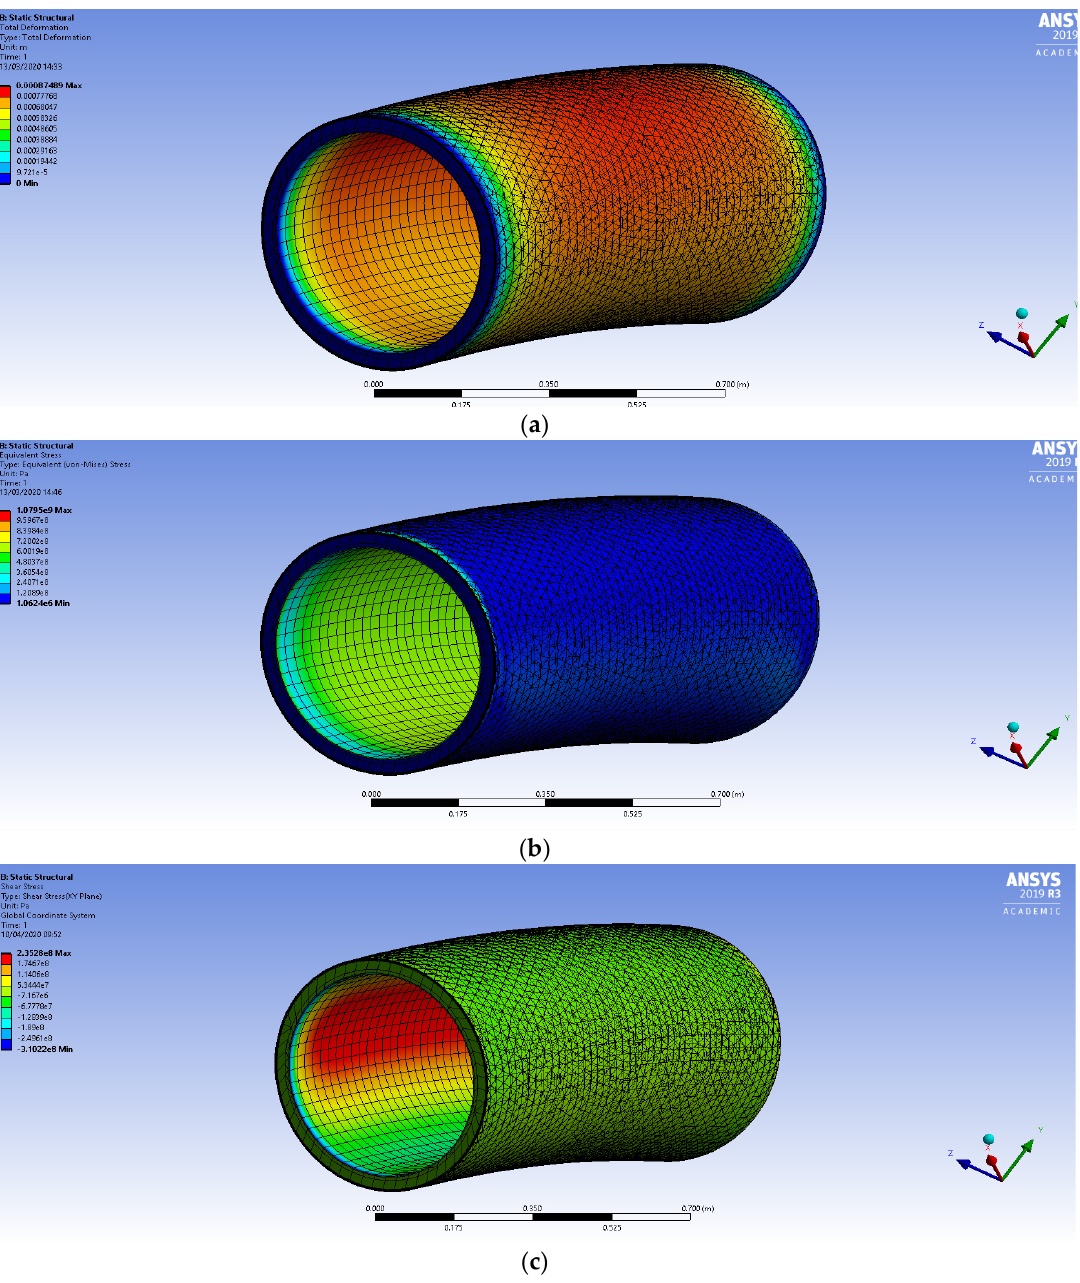
Figure 21. Simplified model of the offshore bonded composite hose for ( a ) total deformation, ( b ) equivalent stress and ( c ) shear stress .